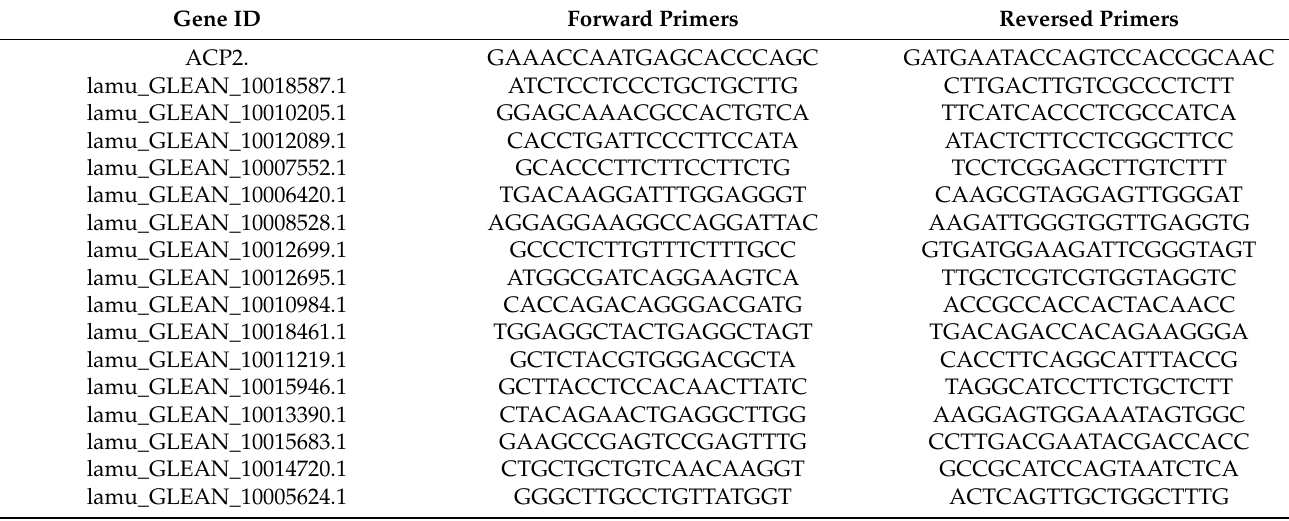
Table 3. Primer sequences for qRT-PCR